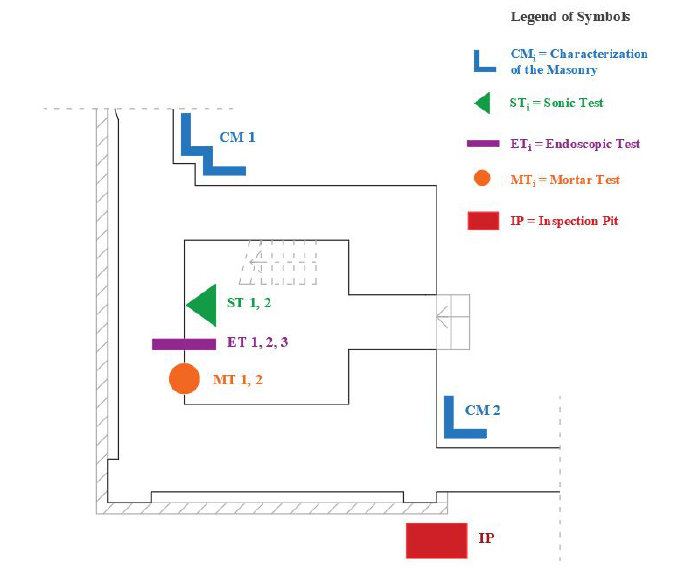
Figure 15. Plan of the diagnostic tests on the